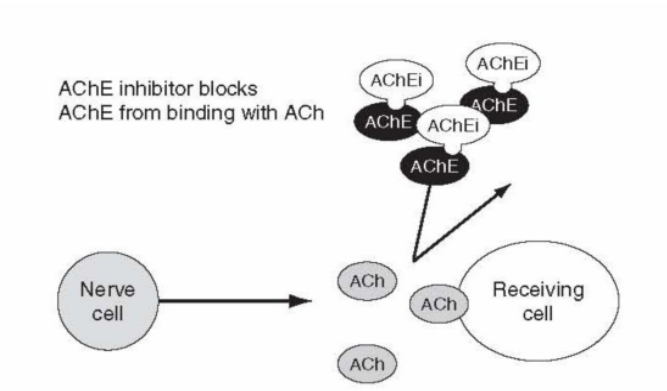
Figure 3: Effect of AChE inhibitors (Organophosphates) [38] The mechanism of toxicity of organophosphates (OP)